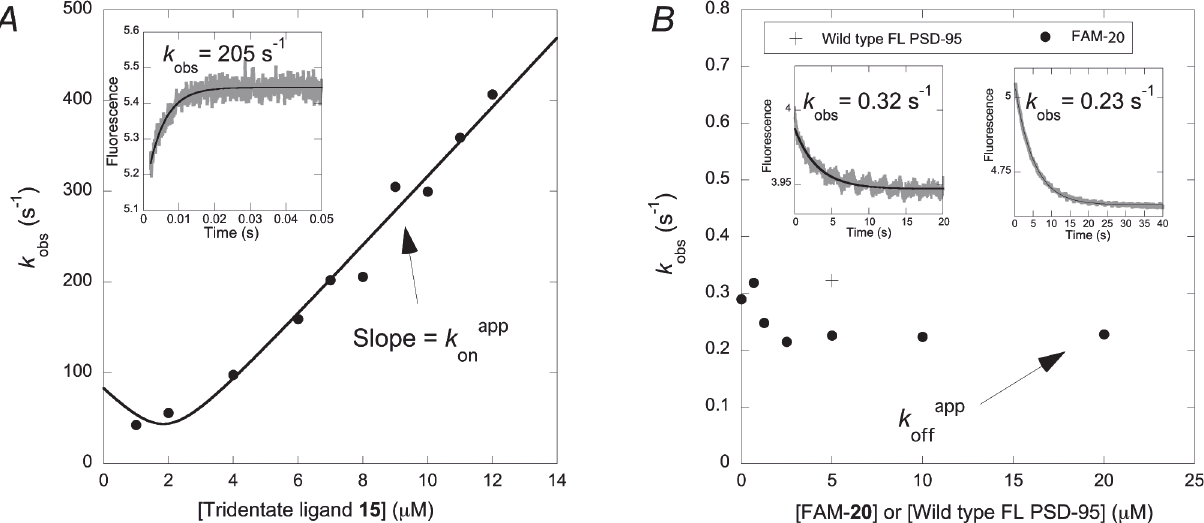
Fig 5. Binding kinetics for the trimeric ligand 15 with FL PSD-95. ( A ) Inset : FL PSD-95 I100W (2 μ M) was mixed with the trimeric ligand 15 (8 μ M). The observed rate constant k obs obtained from such binding traces were plotted versus the concentration of 15 . The slope of the curve in the linear region equals the apparent association rate constant k onapp , as indicated. ( B ) Right inset : A complex of FL PSD-95 (I100W) (1 μ M final concentration) and trimeric ligand 15 (1 μ M final concentration) was mixed with an excess of 5-FAM-labeled dimeric ligand 20 and the change in fluorescence with time was monitored. The k obs values from the displacement experiments were plotted versus concentration of 5-FAM- 20 . At high [5-FAM- 20 ], the k obs of this displacement reaction approaches the overall dissociation rate constant k offapp as indicated by the arrow. Left inset : The complex between FL PSD-95 (I100W) and 15 was displaced by mixing with 5 μ M wild type FL PSD-95. Despite a poor signal-to-noise ratio, this experiment agreed well with the displacement using 5-FAM- 20 .